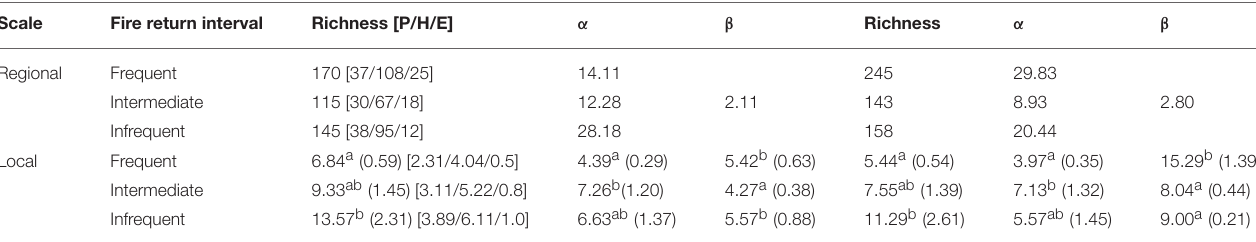
TABLE 2 | Diversity measures for both species and interactions calculated at the regional and local scales for each fire return interval category.